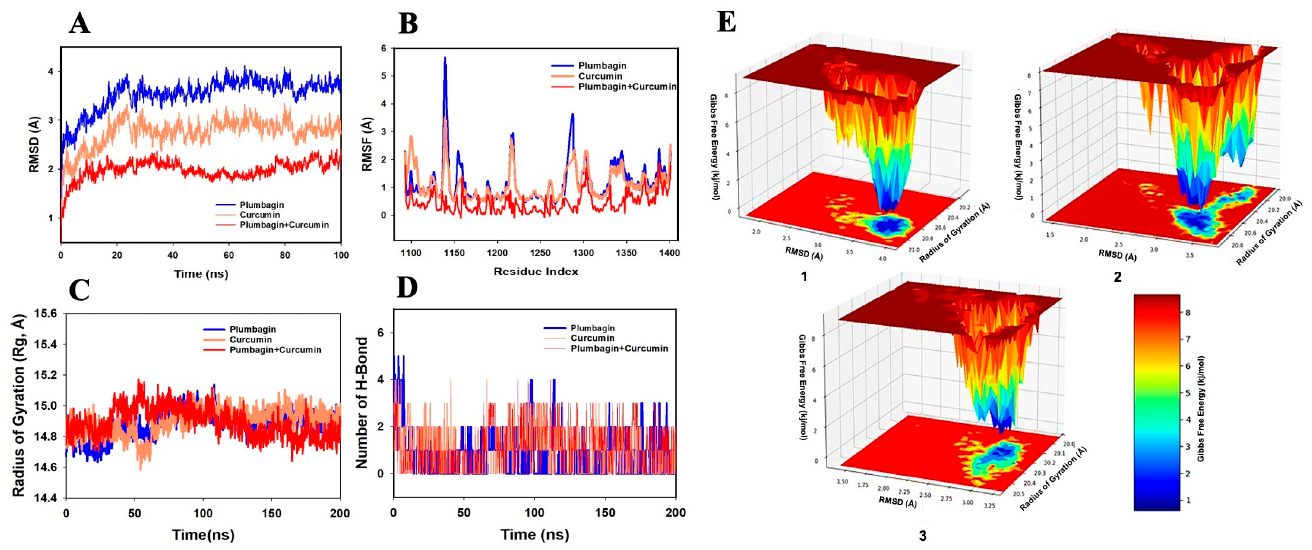
Figure 6. Analysis of MD simulation trajectories with a 100 ns time scale for the interaction of curcumin and plumbagin with Akt. ( A ) RMSD plot displaying the molecular vibration of C α backbone of Akt-P (blue), Akt-C (orange), and Akt-C-P (red). ( B ) RMSF plot showing the fluctuations of respective amino acids throughout the simulation time of 100 ns for Akt-P (blue), Akt-C (orange), and Akt-C-P (red). ( C ) Rg plot for the deduction of compactness of Akt-P (blue), Akt-C (orange), and Akt-C-P (red). ( D ) Number of H-bonds formed between Akt and plumbagin (blue), Akt and curcumin (orange), and Akt and curcumin–plumbagin combination (red). ( E ) The FEL displays the progression of global minima ( Δ G, kJ/mol) of Akt in presence of ( 1 ) plumbagin, ( 2 ) curcumin, and ( 3 ) curcumin–plumbagin combination with respect to their RMSD (Å) and Rg (Å). The lower right panel displays the energy scale used in the measurement of FEL.